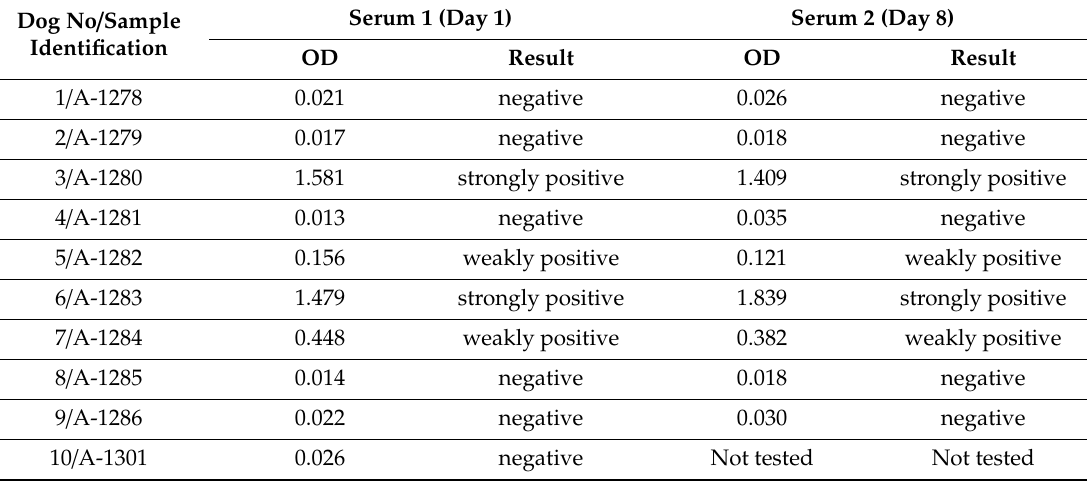
Table 1. Detection of IgG antibodies by ELISA in sera from hunting